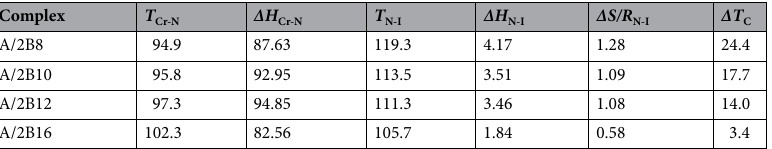
Table 1. Temperature of phase transition (°C), enthalpy of transitions (kJ/mol), normalized entropy and the nematic temperature range ( ∆T C ) for the present complexes A/2Bn . Cr–N crystal-nematic phase; N-I nematic- isotropic liquid. ∆T C = Nematic range.